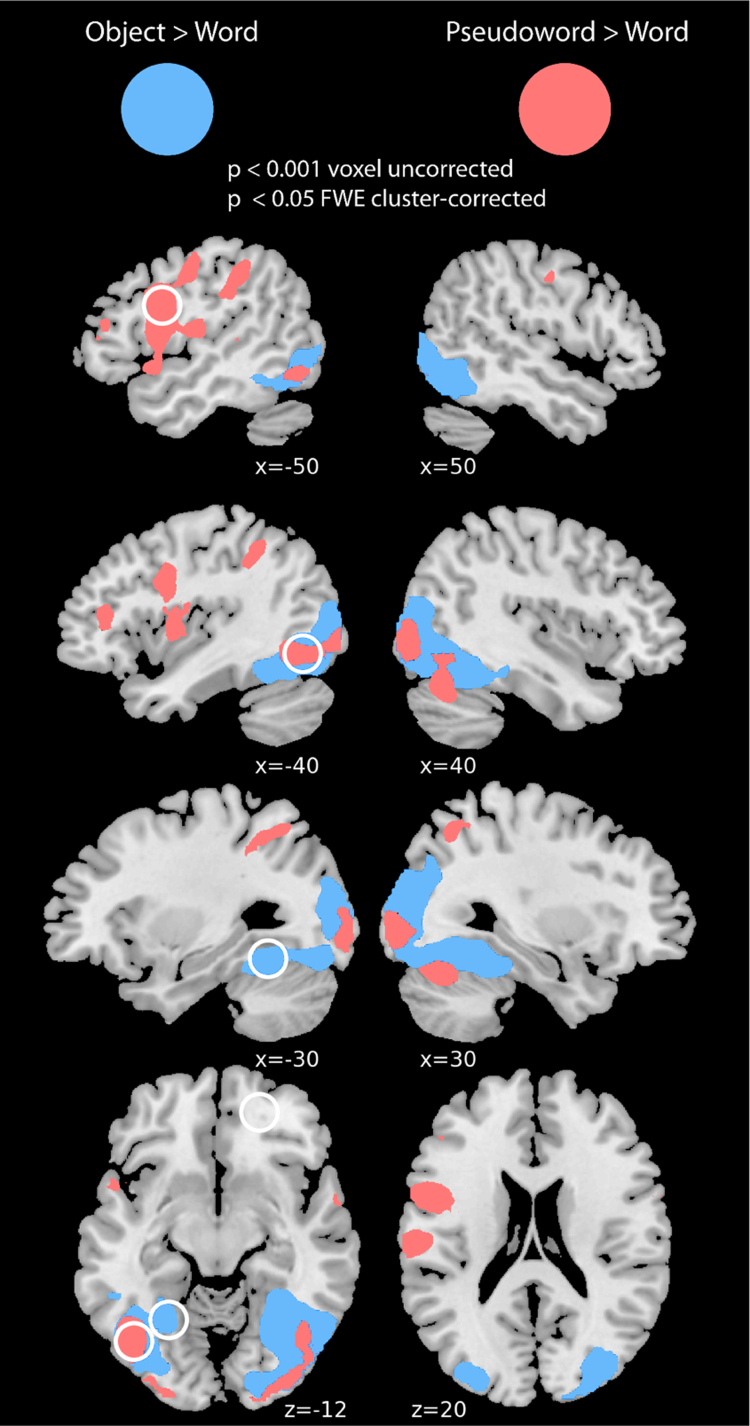
Brain regions showing differential activation for contrasts of interest from functional localiser displayed on the MNI standard brain. Red=[pseudowords – words], blue=[objects - words]. Slices show activations at p<0.001 voxel-wise uncorrected and p<0.05 FWE cluster corrected. White circles indicate approximate locations of regions of interest defined from the functional localiser.